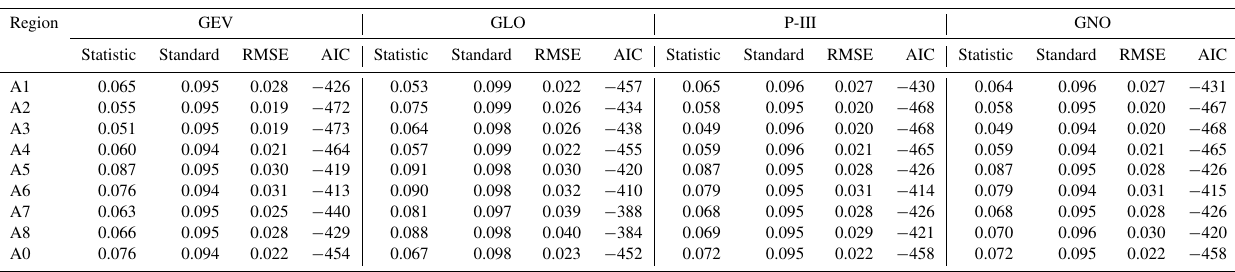
Figure 4. Empirical and theoretical CDFs of precipitation of sub-regions and the entire region using the GNO distribution. On the x axis, the Hessian scale transferred by using the standard normal distribution was used. Table 3. Goodness-of-fit test of univariate distributions of precipitation of sub-regions and the entire region. The standard (value) refers to the statistic of the significance level of